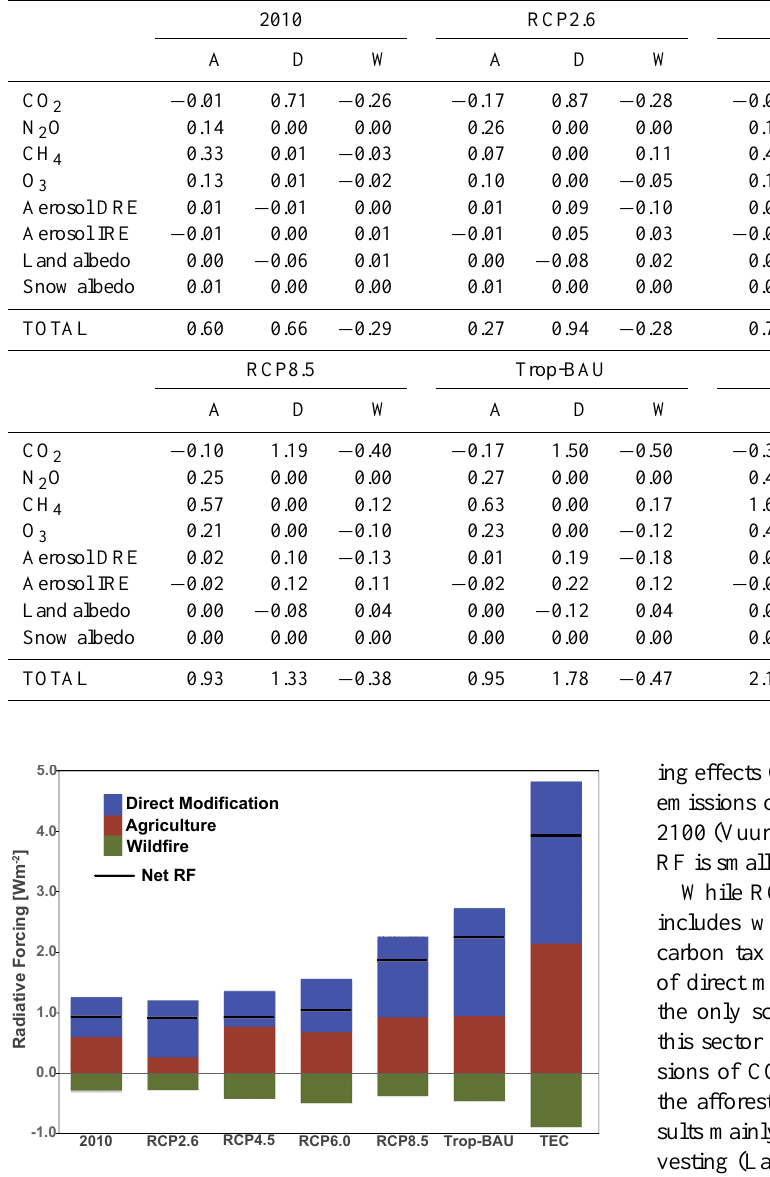
Figure 2. The fraction of radiative forcing from each main sector as defined in Fig. 1. The forcings are reported for the year 2010 (2010) or in year 2100 (RCP2.6, RCP4.5, RCP6.0, RCP8.5, Trop-BAU,